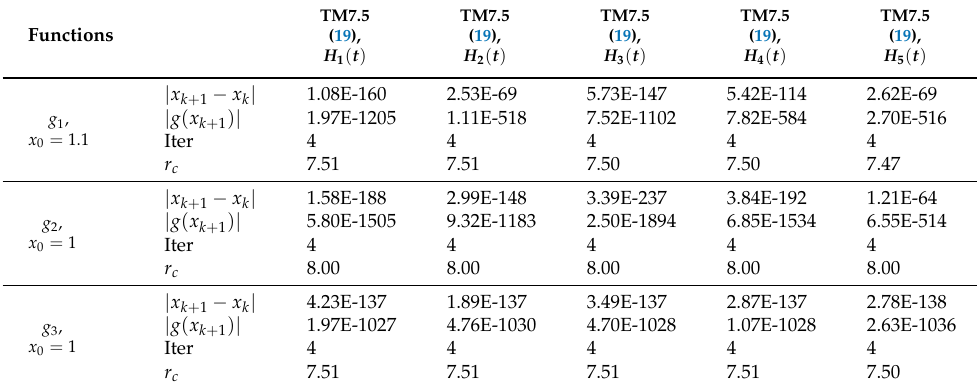
Table 5. Comparison of various iterative schemes (fifth part).